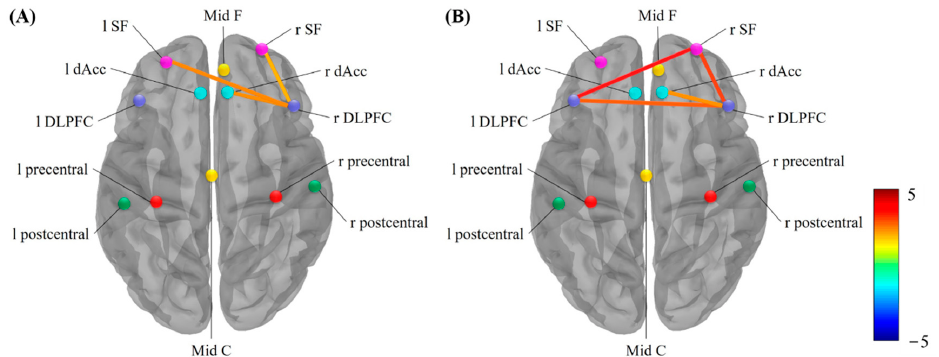
Figure 6. Functional connectivity within the executive functional network based on PLV, the color of the color bar represents the size of the t value. Abbreviations: Mid F, mid frontal cortex; r SF, right superior frontal; l SF, left superior frontal; r dAcc, right dorsal anterior cingulate cortex; l dAcc, left dorsal anterior cingulate cortex; r DLPFC, right dorsal lateral prefrontal cortex; l DLPFC, left dorsal lateral prefrontal cortex; Mid C, mid-central cortex; l precentral, left precentral cortex; l postcentral, left postcentral cortex; r precentral, right precentral cortex; r postcentral, right postcentral cortex. ( A ) Differences between string musicians and the control group ( p < 0.05). ( B ) Differences between pianists and the control group ( p <